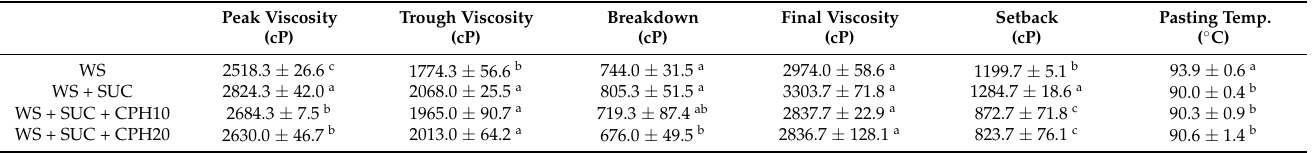
Figure 2. Pasting curves of wheat starch with added sucrose and citrus peel hydrolysates. WS, wheat starch; SUC, sucrose; CPH10, citrus peel hydrolysate 10%; CPH20, citrus peel hydrolysate 20%. Table 2. Pasting properties of wheat starch with added sucrose and citrus peel hydrolysates. Peak Viscosity